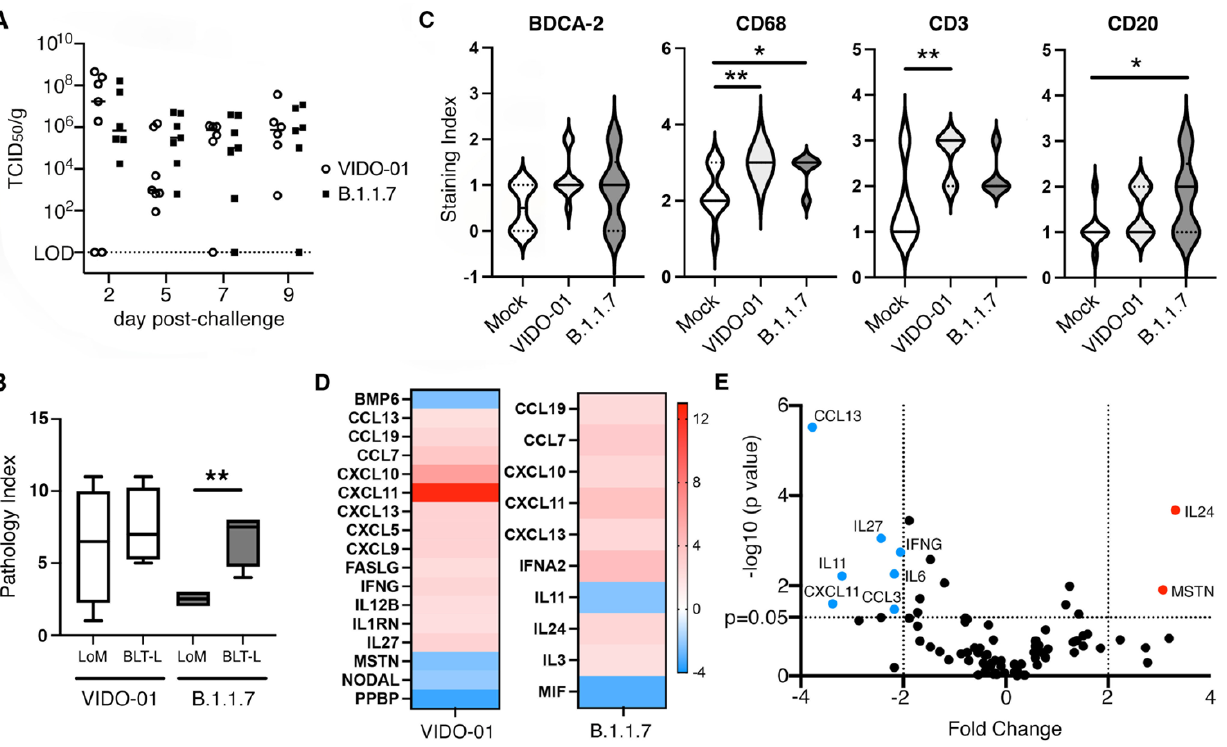
Figure 5. Human immune responses to SARS-CoV-2 in lung organoids. ( A ) Lung organoids im- planted onto TKO mice in the absence of a systemic human immune system were challenged with 1 × 10 5 TCID 50 of B.1.1.7 or VIDO-01 and infectious viral titers determined at days 2, 5, 7 and 9. Each dot represents an individual lung organoid. Horizontal lines denote mean. LOD = Limit of detection. ( B ) Histological scores of lesions (pathology index) in lung organoids from animals that either were (BLT-L) or were not (LoM) implanted with a human immune system and infected with either VIDO-01 or B.1.1.5 for 5 days. Unpaired t-test. ** = p < 0.01. ( C ) Level of human BDCA-2, CD68, CD3 and CD20-specific immunohistochemical staining in lung organoids from uninfected and SARS-CoV-2 variant infected TKO-BLT-L mice at day 5 post infection. * = p < 0.05, ** = p < 0.01. Solid line denotes mean and dotted lines SD, n = 3 per group. One-way ANOVA with Tukey’s posttest. ( D ) Lung organoids from TKO-BLT-L mice infected with VIDO-01 or B.1.1.7 were assessed for expression of human chemokine and cytokine genes using a RT-PCR Array. Fold changes were calculated via ΔΔ Ct against the control group at day 5 relative to housekeeping genes. At least six lung organoids were analyzed for each group. ( E ) Volcano plot of differentially expressed genes in B.1.1.7 (red) compared to VIDO-01 (blue) infected lung organoids.